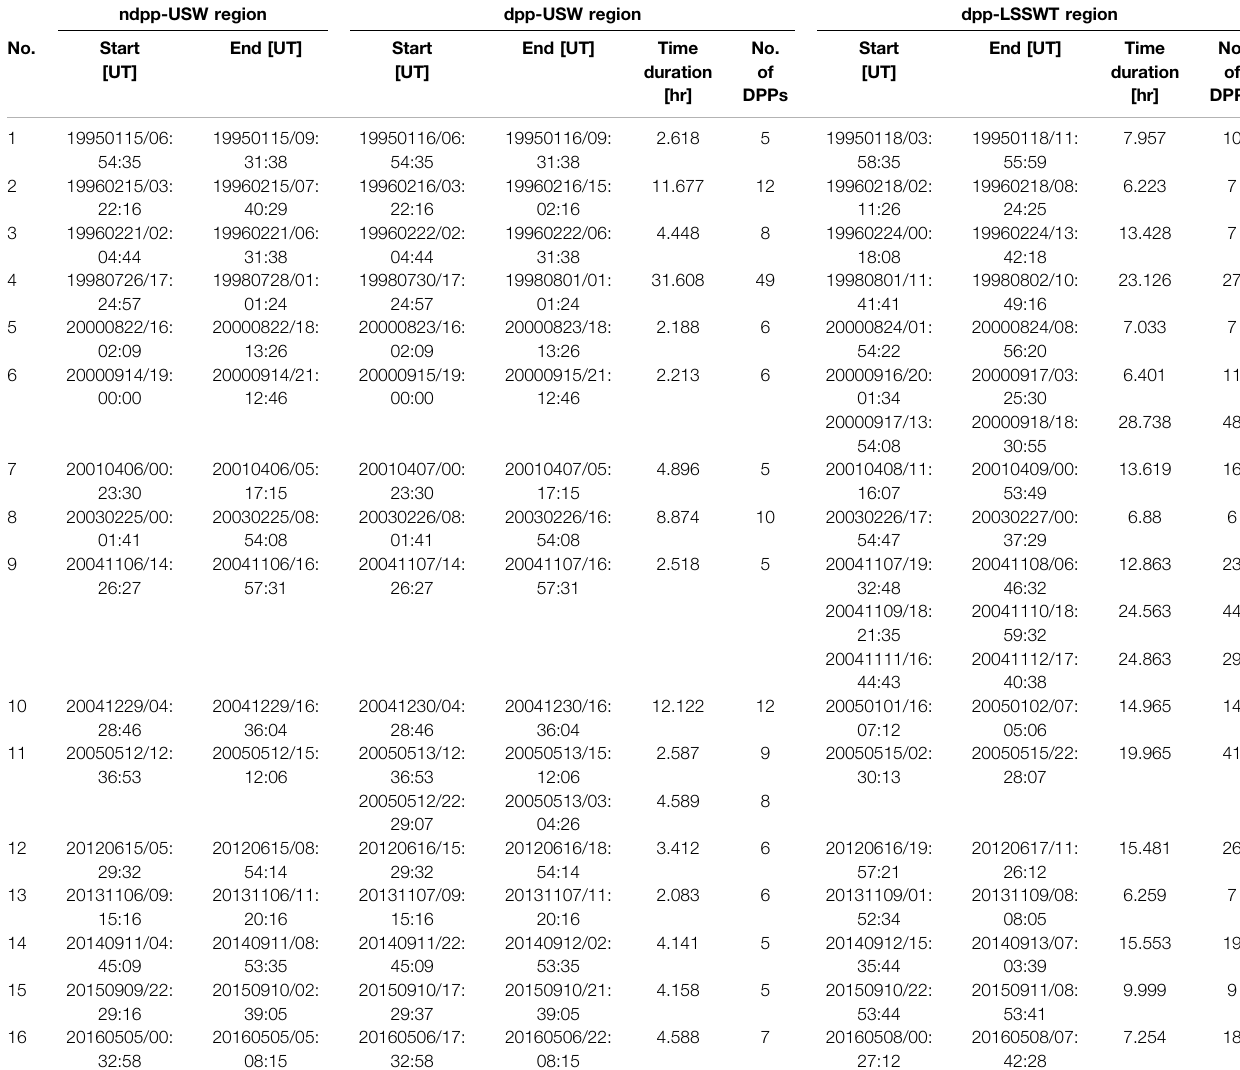
TABLE 2 | The time information of selected 16 events. The start time, end time, time duration, and number of DPP events are listed separately. The time duration of ndpp- USW region is same as that of the dpp-USW region and listed in Column 6. ndpp-USW region dpp-USW region dpp-LSSWT